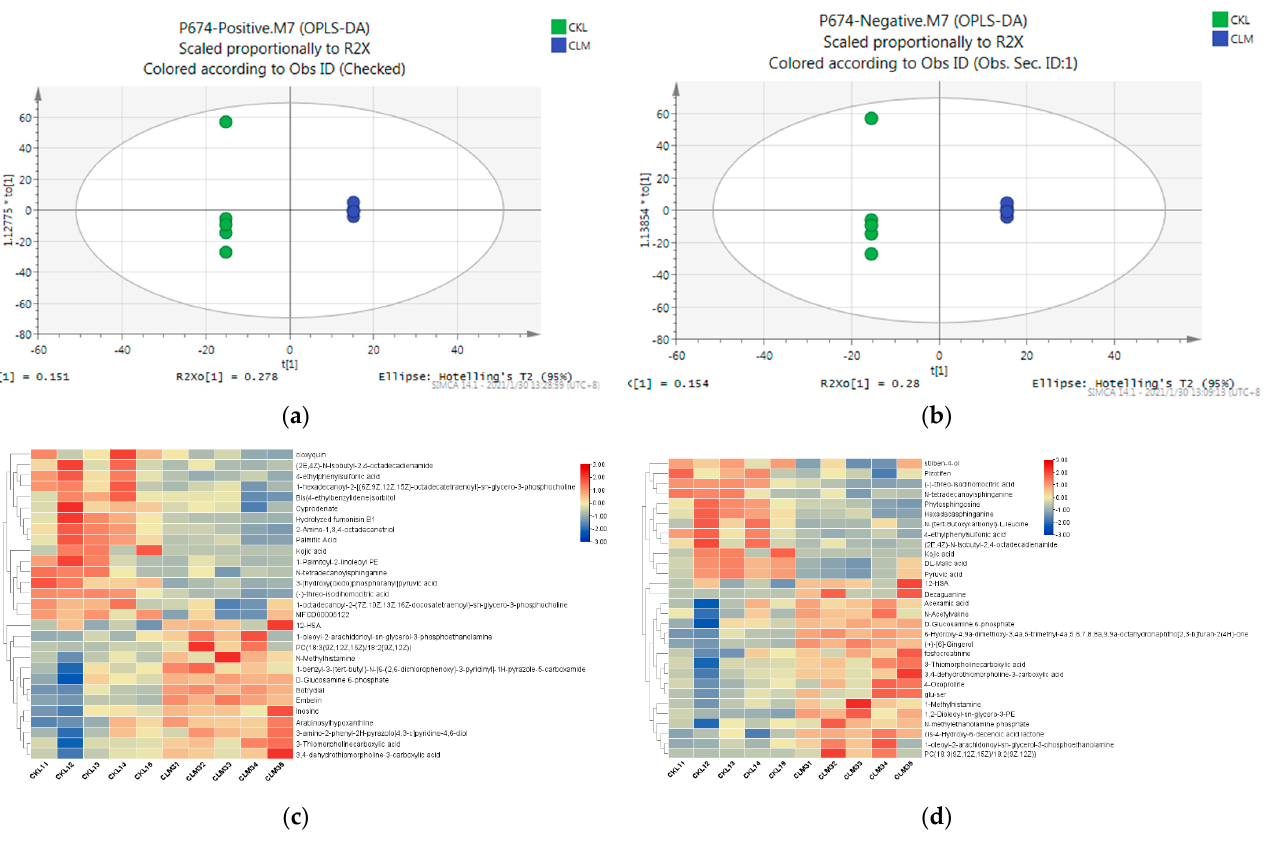
Figure 4. OPLS − DA score plots derived from HILIC UHPLC − Q − EXACTIVE/MS in positive ( a ) and negative ( b ) ionization modes. Samples in the Cd group were separated from those in the control group. R2 X and R2 Y indicate the fraction of the variables explained by the model, and the Q2 shows the predictive abilities of the model. Control versus Cd, ESI+: R2 X = 0.781, R2 Y = 1.000 and Q2 = 0.794; ESI-: R2 X = 0.799, R2 Y = 1.000 and Q2 = 0.802. Hierarchical clustering heat map, correction analysis, and pathway analysis of metabolites that were obtained from the liver. Unsupervised hierarchical clustering heat map of metabolites from liver of goats in the positive mode ( c ) and negative mode ( d ). Cluster of the changed metabolites (right side) and the samples in different groups (bottom). The color of the heatmap from red to blue indicated the relative intensity of the metabolites.